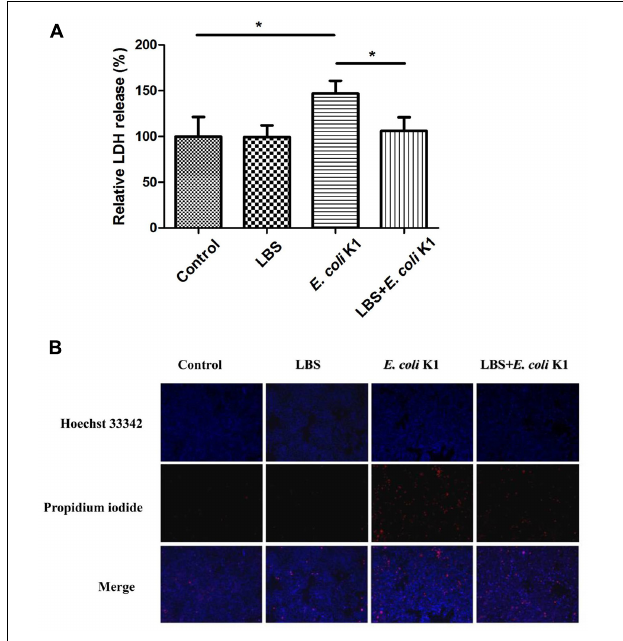
FIGURE 3 | Pre-treatment with LBS decreases E. coli K1-induced damage and apoptosis of HT-29 cells. HT-29 cells were treated as described in Figure 1 . (A) LDH activity was analyzed by microtiter plate reader and the results were expressed as a percentage of the control (untreated cells). Results are presented as mean ± SD. ∗ P < 0.05. (B) HT-29 cells were illustrated by fluorescence microcopy (100 × magnification). Hoechst 33342 was used to stain nuclei of all cells (blue), PI was used to detect the dead cells